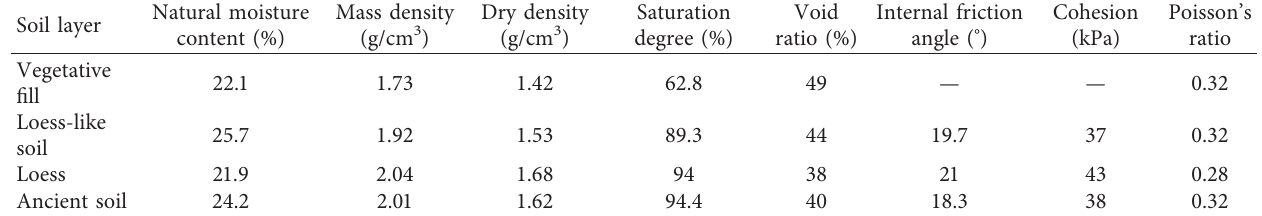
Table 2: Soil physical index.